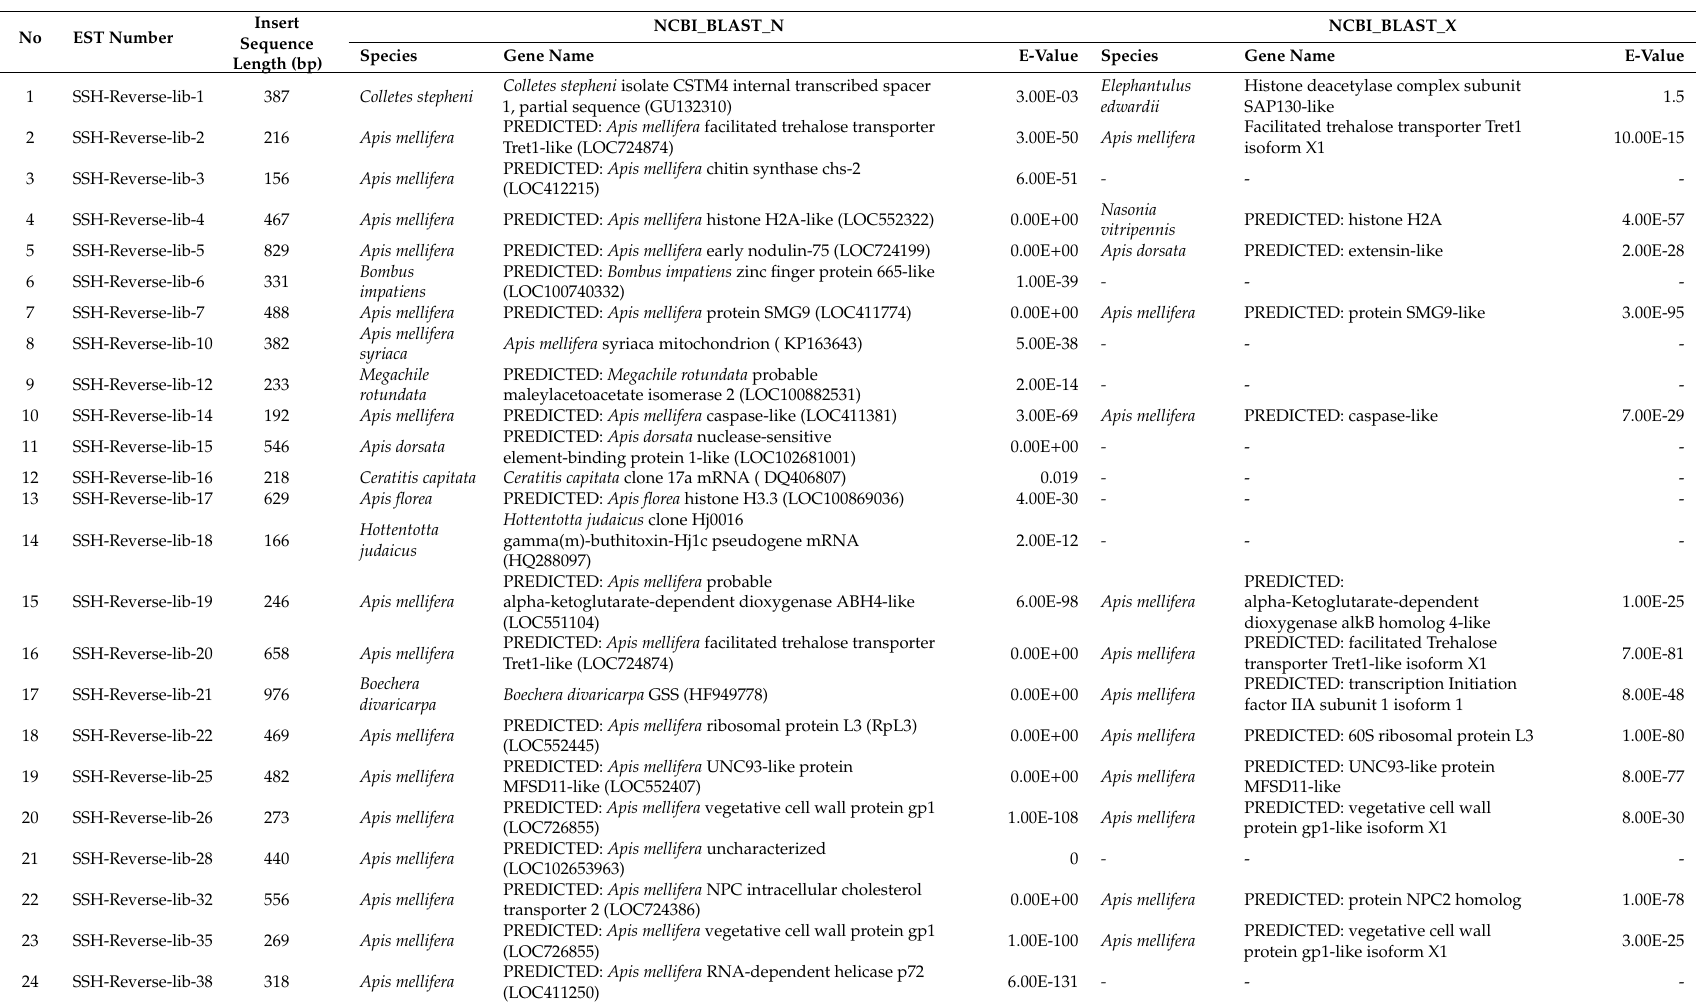
Table 3. Analysis of 53 di ff erential expressed sequence tags (ESTs) identified from reverse cDNA